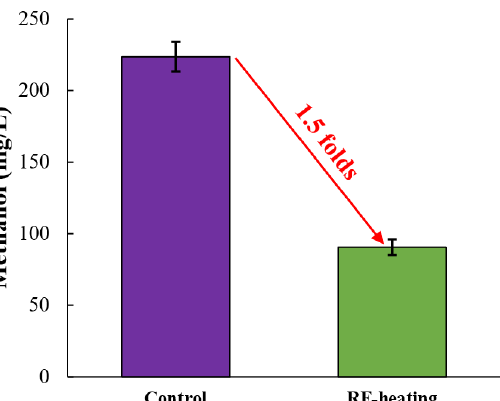
Figure 4. Comparison of methanol contents of the fermentation broth of red jujubes with and without RF heating treatment.